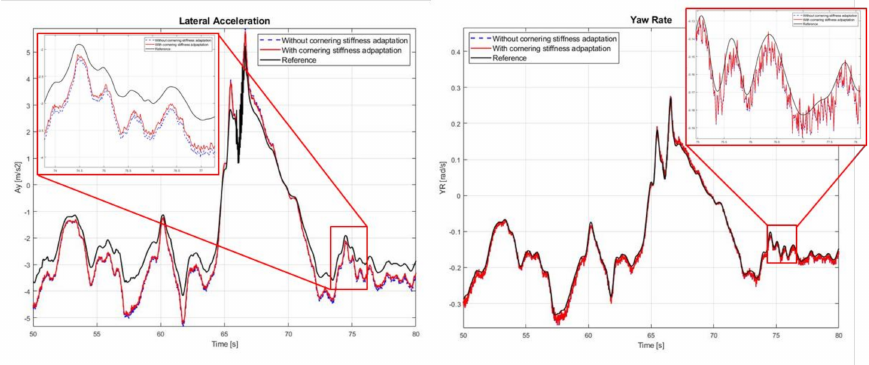
Figure 12. Effect of cornering stiffness estimation in Case